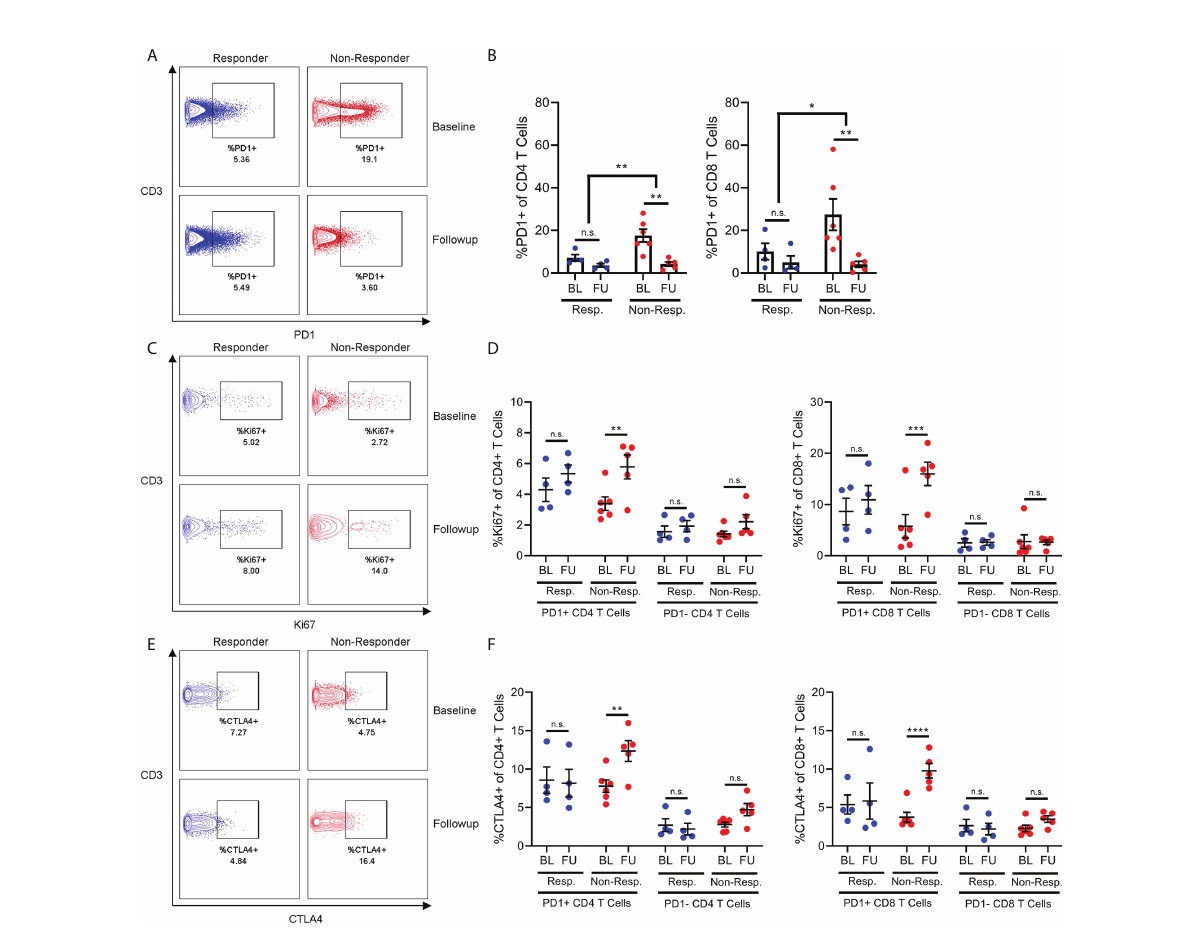
FIGURE 2 The frequency of PD1+ T-cells in non-responders decreases following exposure to checkpoint inhibition (A, B) , but this is associated with a signi fi cant increase in expression Ki67 (C, D) and CTLA4 expression (E, F) in these cells. N.S, not signi fi cant; *p<0.05; **p<0.01; ***p<0.001;